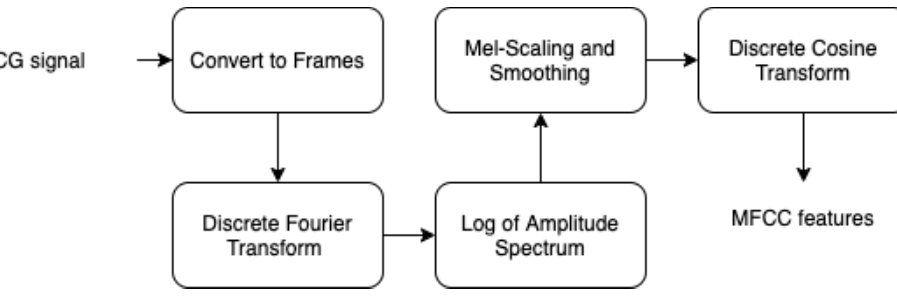
Figure 17. Mel spectrogram steps.